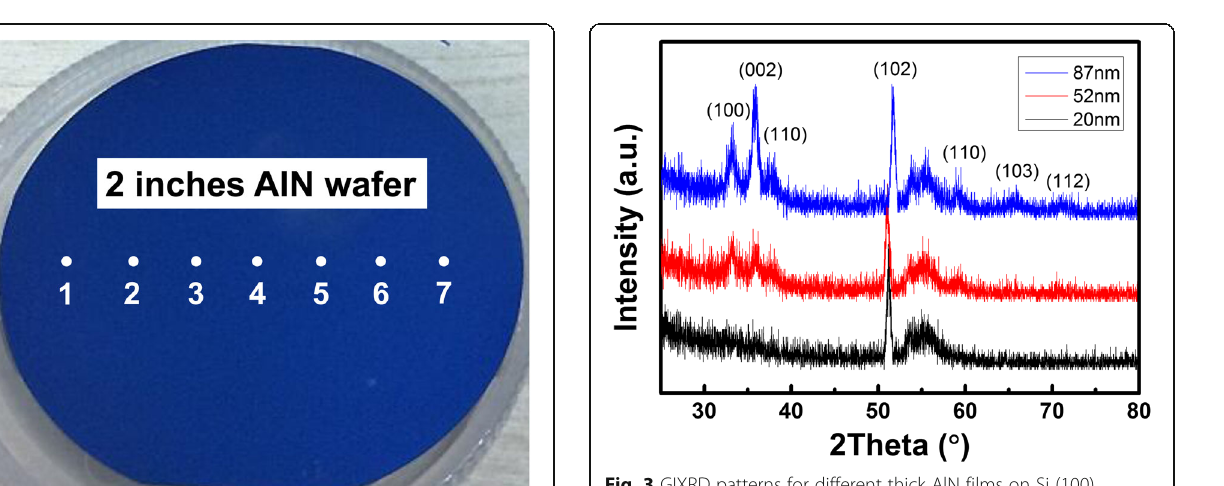
Fig. 3 GIXRD patterns for different thick AlN films on Si (100) at 300 °C